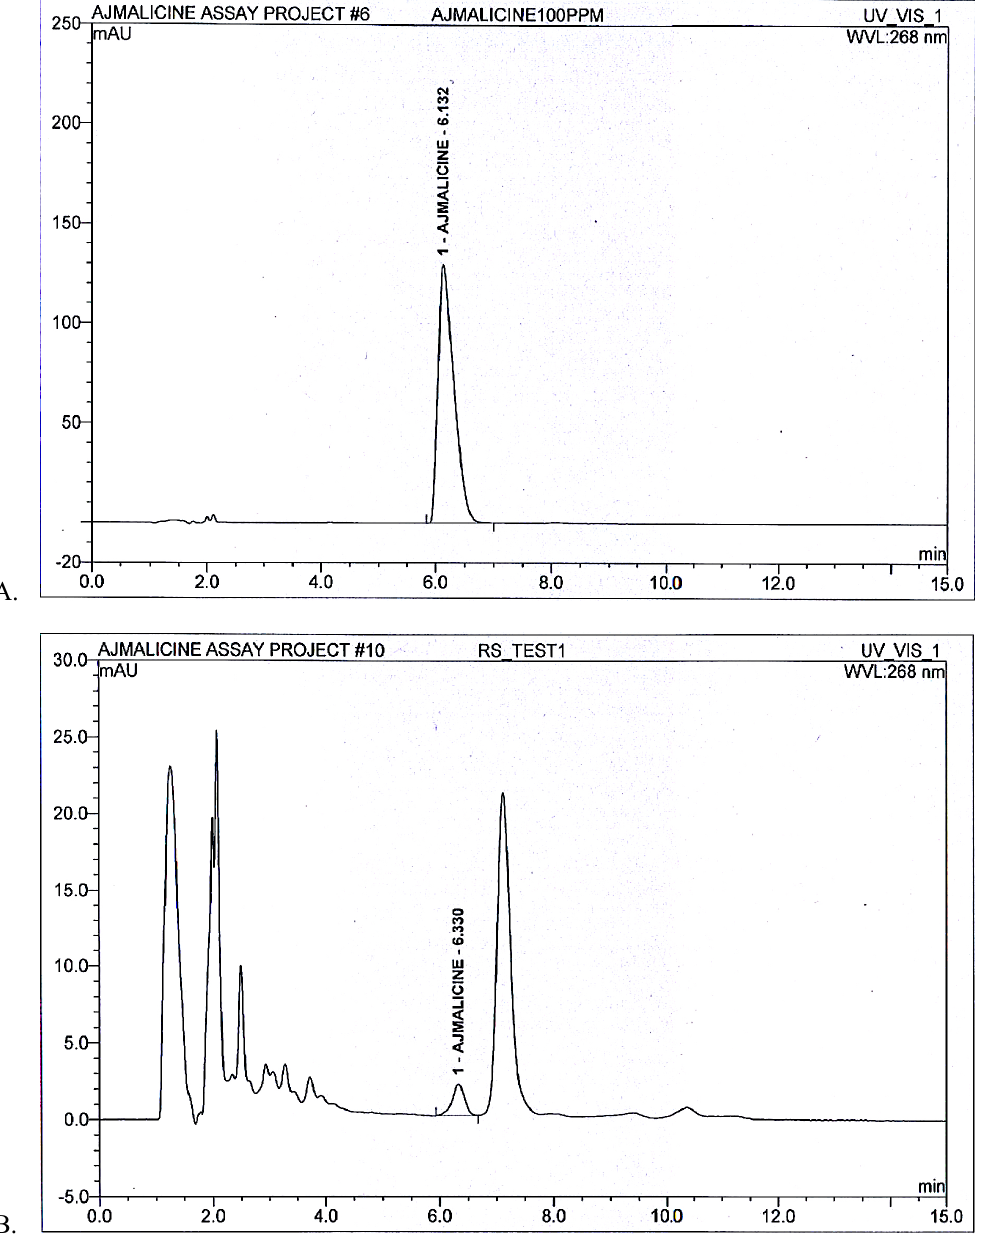
Figure 4. ( A ) Standard peak ( B ) R. serpentina test extract resolved peaks at 6.0 min and 6.3 min, respectively, for AJM quantification analysis using developed RP-HPLC method at 268 nm.